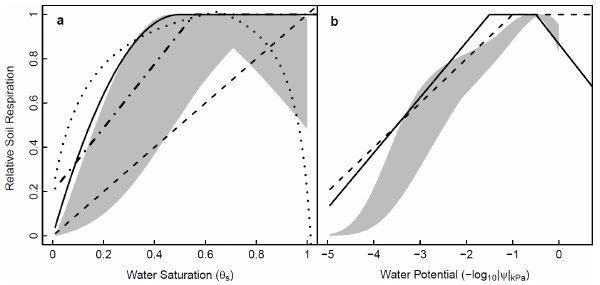
514 Fig. 4. Comparison of predicted relative soil heterotrophic respi- Figure 4: Comparison of predicted relative soil heterotrophic respiration as a function of soil mois-515 ration as a function of soil moisture. The grey area marks the full ture. The grey area marks the full range of values obtained with Eqs. (3) and (5) using  s ( a ) or  log ( b ) 516 range of values obtained with Eqs. (3) and (5) using θ s (a) or ψ log (b) for 106 soil series from England and Wales ranging from 8 to for 106 soil series from England and Wales ranging from 8 to 50 mg g -1 SOC and 0.08 to 0.61 clay 517 50mgg − 1 SOC and 0.08 to 0.61 clay fraction. Other lines are fraction. Other lines are moisture-respiration functions from existing models using either  s ( a ) or 518 moisture-respiration functions from existing models using either θ s  log ( b ) as a predictor. In panel a : CANDY model (full line), Bethy model (dashed line), SimCycle mod-519 (a) or ψ log (b) as a predictor. (a) : CANDY model (full line), Bethy model (dashed line), SimCycle model (dotted line), RothC model el (dotted line), RothC model (dot-dash line). In panel b : Daisy model (full line), SOILCO2 model 520 (dot-dash line). (b) : Daisy model (full line), SOILCO2 model (dashed line). 521 (dashed